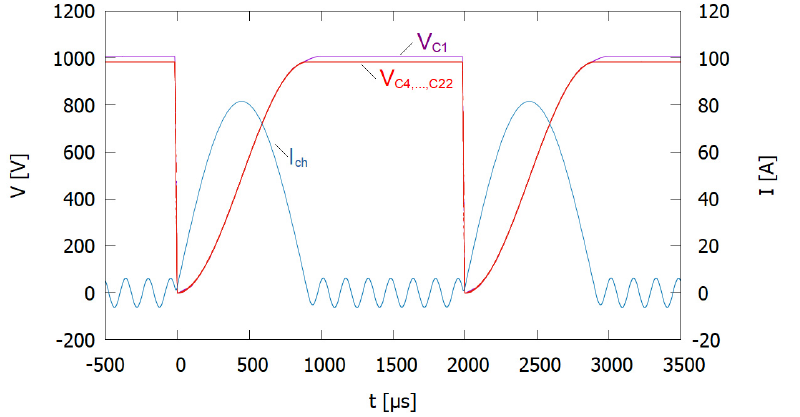
Figure 5. Simulated voltages across the stage capacitors C1, C4, C7, C10, C13, C16, C19, and C22 according to Figure 3, together with the generator’s charging current I ch (R D : open circuit).